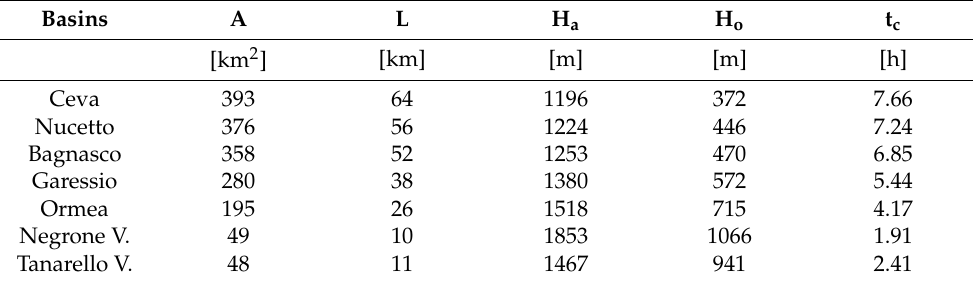
Table 2. Parameters required by (3) for the evaluation of the concentration time (t c ) and results for each of the five sub-basins of the UTV and for Negrone and Tanarello valleys.